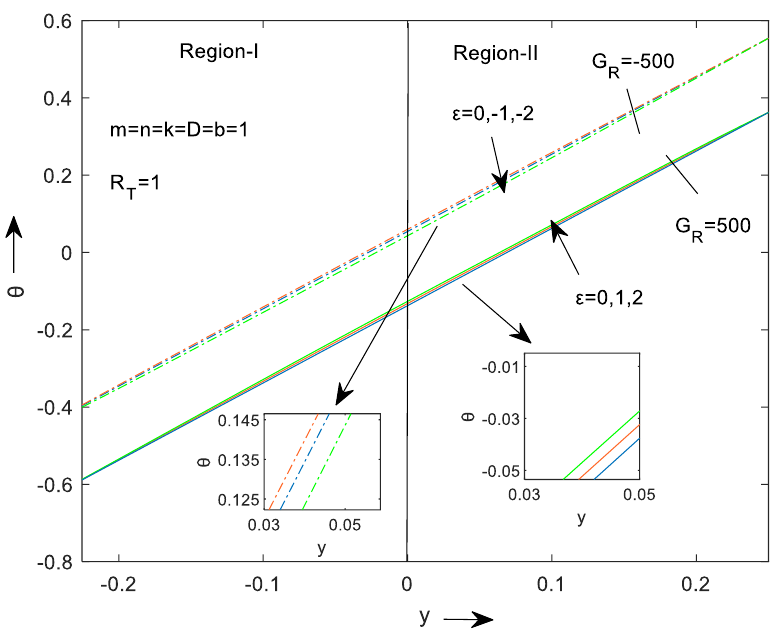
Fig. 4b. Temperature profile for different values of